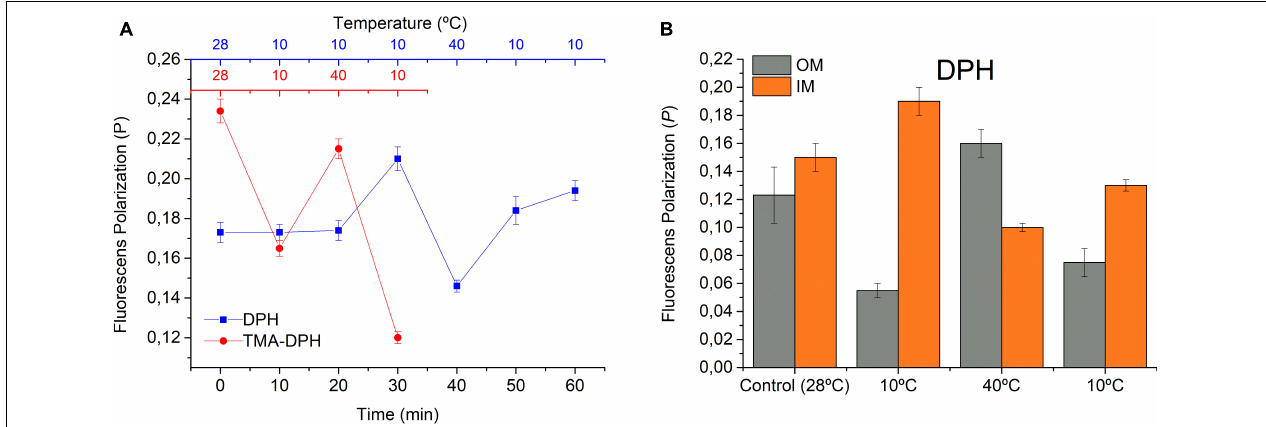
FIGURE 2 | Effect of fast cyclic temperature changes on the fluorescence polarization. (A) Using DPH and TMA-DPH as fluorescent probes in whole S. meliloti cells and (B) using DPH in OM and IM. S. meliloti culture was grown to a stationary phase at 28 ◦ C, centrifuged, and the biomass resuspended in 15 mmol L − 1 Tris–HCl buffer (pH 7.0) up to an OD600 nm = 0.2. The fluorescent membrane probes (DPH or TMA-DPH) 4 µ mol L − 1 were added to the resuspended culture (3 mL). Fluorescence polarization was measured in one aliquot at time = 0 min at 28 ◦ C (control sample) and after each successive temperature change. OM and IM (spheroplast) fractions from control cells were incubated with DPH probe 4 µ mol L − 1 and were subjected to rapid changes in temperature (10 min), and the fluorescence polarization was determined. Values represent the mean ± sd of three independent experiments.